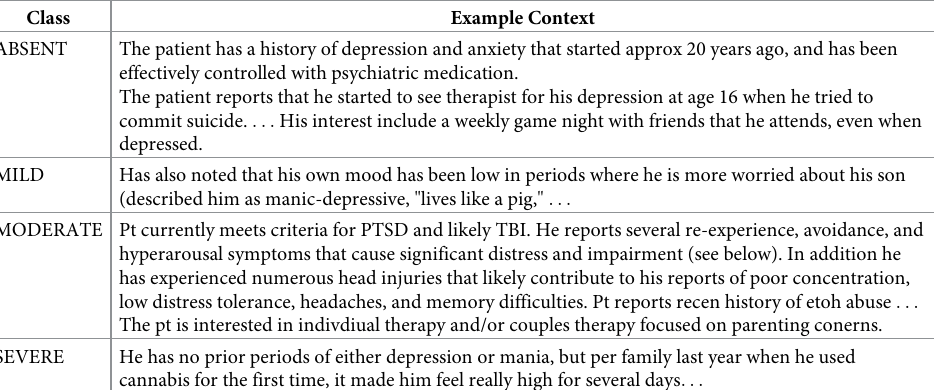
Table 6. Examples of vague descriptions across different